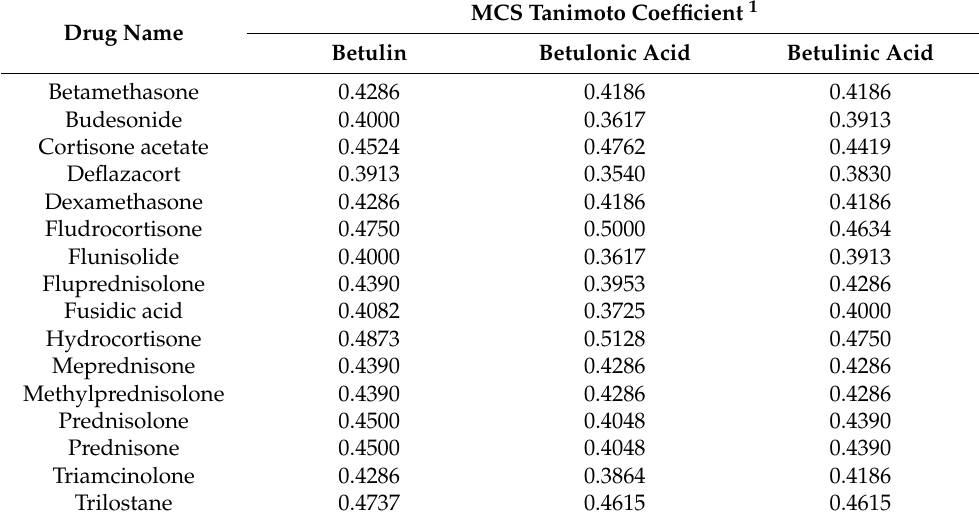
Table 1. Results of maximum common substructures (MCS) search for betulin, betulonic, and betulinic